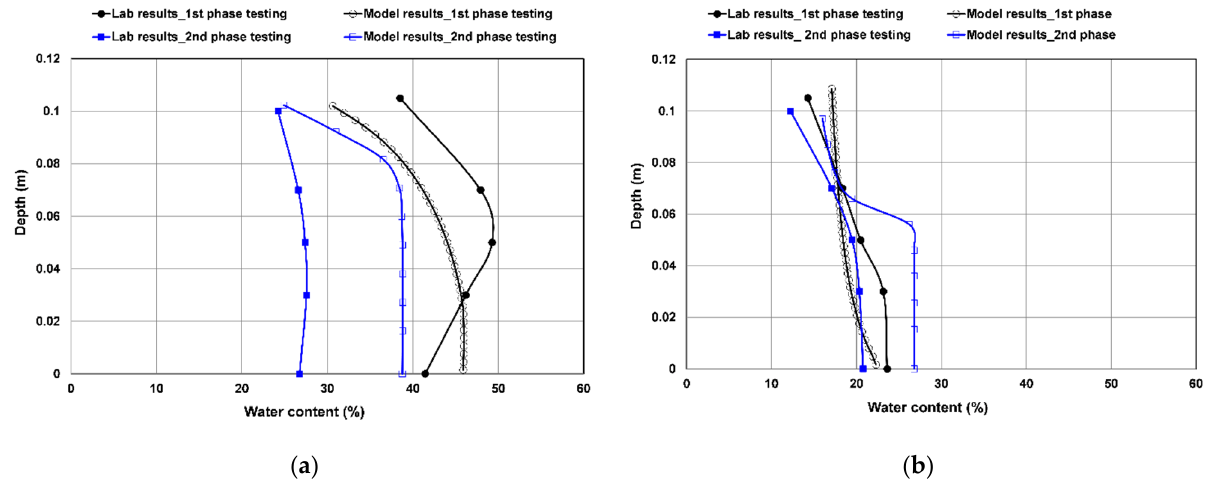
Figure 11. Laboratory versus. model water content profiles of centrifuged tailings at the end of the test under a temperature gradient of ( a ) 0.083 °C/mm and ( b ) 0.028 °C/mm.